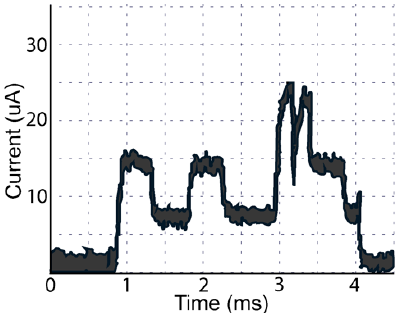
Figure 3. Each bottle squeeze consumes ~12 μ A for 3 ms. Intact bottles can achieve >1000 pushes and BLE transmissions while battery voltage is over 1.8 V, the minimum input voltage for the Cypress programmable system on a chip